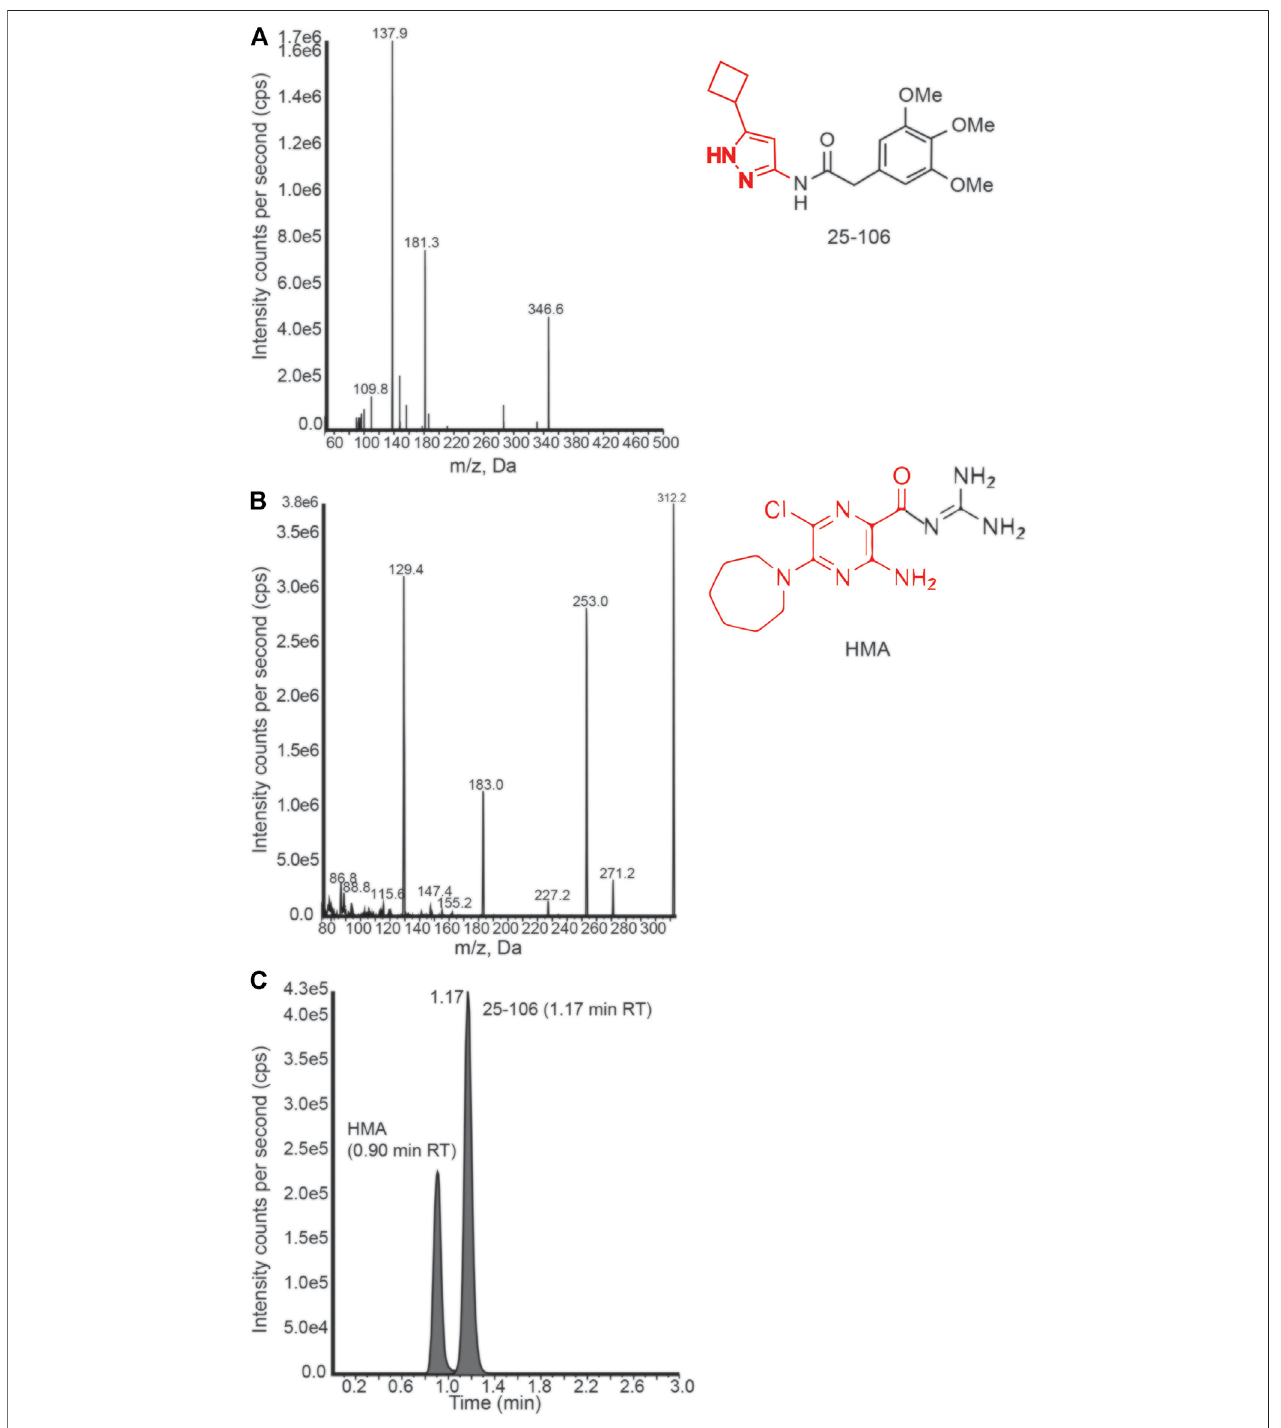
FIGURE 5 | LC-MS/MS detection of 25 – 106 (A) . Mass spectrum peaks generated from ion fragmentation of parent compound 25 – 106 (right). Major peak (137.9 highlightedinred). (B) Massspectrumpeaksgeneratedfromtheionfragmentationinternalstandard(IS)HMA(right).Majorpeak(129.4outlinedred). (C) Chromatogram of 25 – 106 (125 ng) and HMA (100 ng) mixture displaying two temporally distinct peaks.